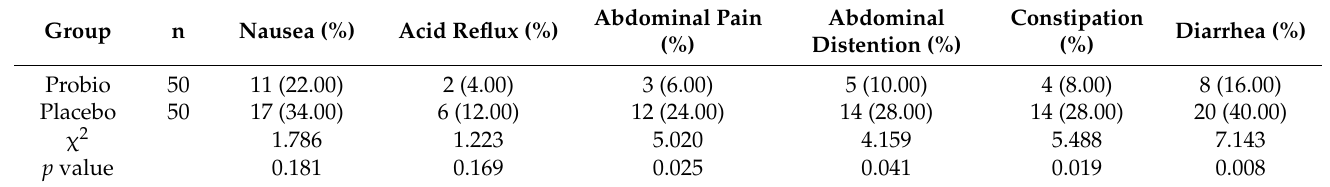
Table 2. Comparison of incidence of gastrointestinal adverse reactions after chemotherapy.